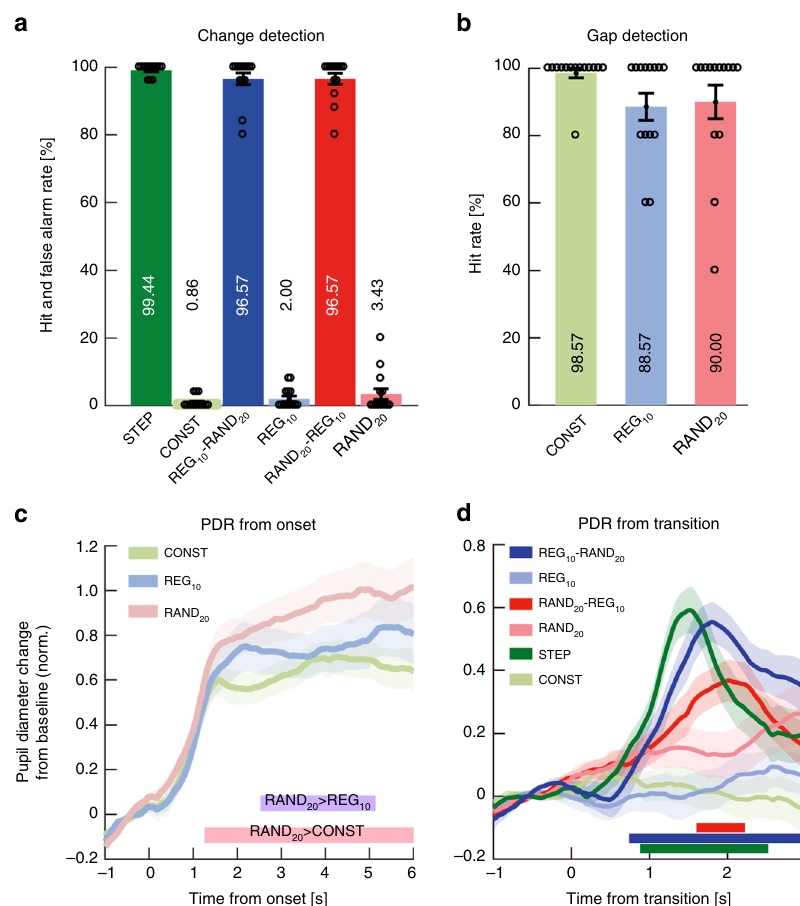
Fig. 8 Experiment 3B ( n = 14): Active transition detection (delayed response). a Transition detection task: Hit rates and false positive rates. Circles indicate individual subject data; error bars are ±1 SEM. b Gap detection task. c Average pupil diameter over time relative to sequence onset. Colored lines indicate time intervals where cluster-level statistics showed signi fi cant differences between conditions. RAND 20 statistically diverged from CONST at 1260 ms through to sequence offset and from REG 10 between 2520 ms and 5120 ms post-onset. d Average pupil diameter relative to the transition. Shading shows ±1 SEM. Colored horizontal lines indicate time intervals where cluster-level statistics showed signi fi cant differences between each change condition and its control. The PDR to STEP increased from ~200 ms post-transition, peaking at 1520 ms; it statistically diverged from CONST between 880 and 2520 ms. For REG 10 -RAND 20 , the responses commenced ~500 ms post-transition, peaking at 1800ms, and statistically diverged from REG at 740 ms post-transition through to sequence offset. For RAND 20 -REG 10 , the response rose at 1000 ms, peaked at 2020 ms, and statistically diverged from its control RAND